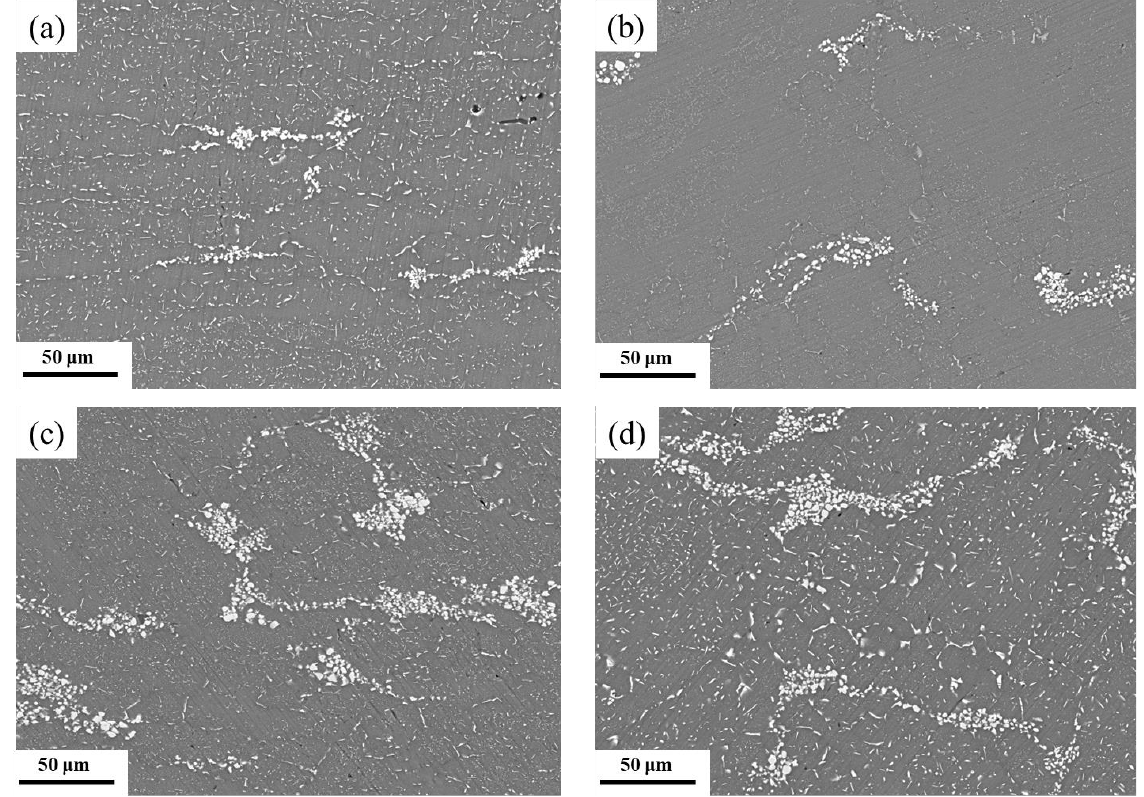
Figure 4. SEM images of the 7085 alloys: ( a ) initial sample without deformation and the sample deformed at ( b ) 450, ( c ) 250, and ( d ) − 180 °C.